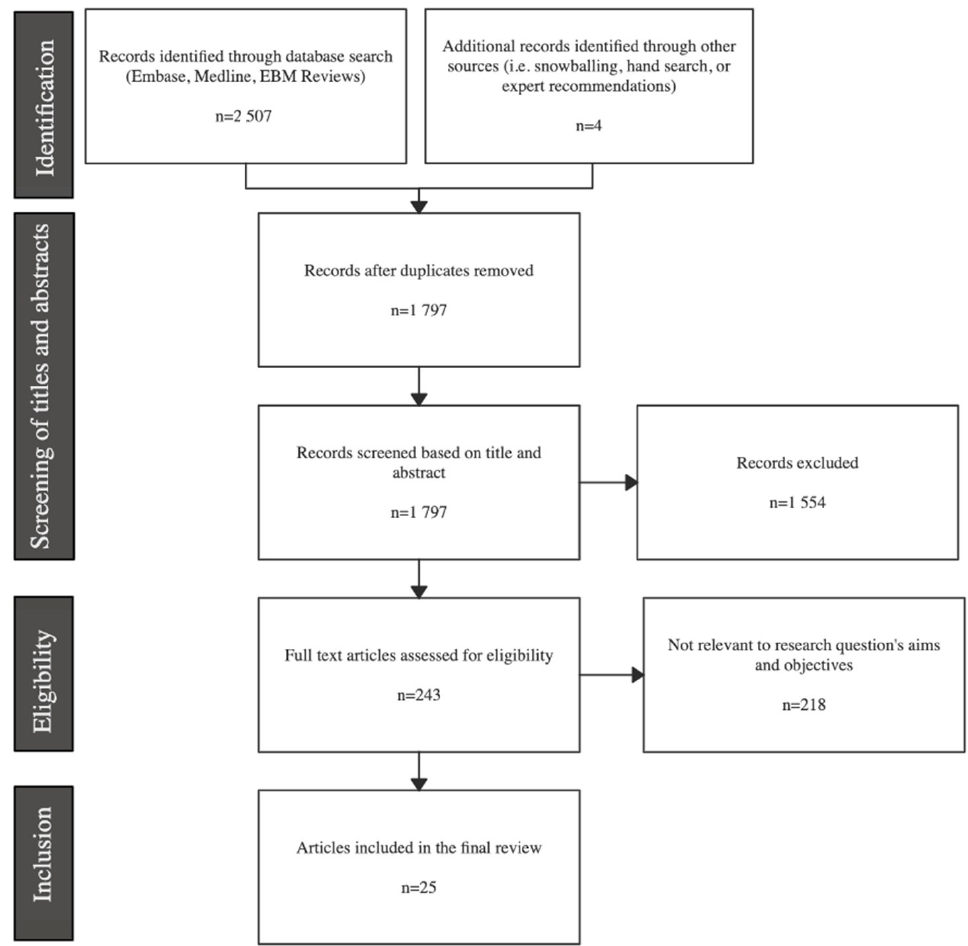
Figure 1. Prisma flow diagram.